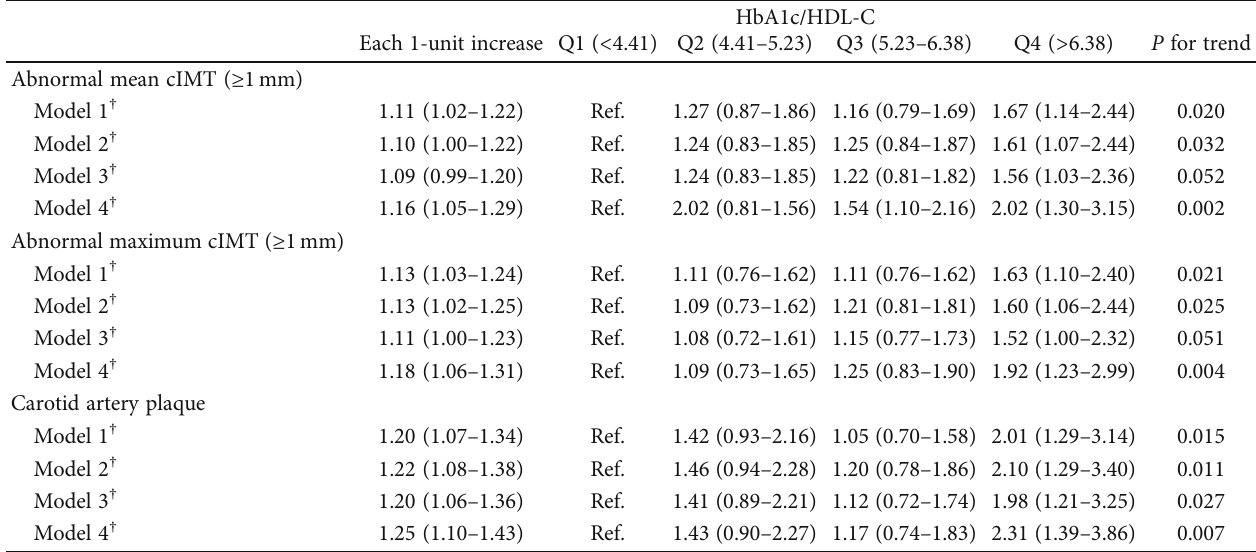
Table 4: OR (95% CIs) of abnormal cIMT and carotid artery plaque by quartiles of the HbA1c/HDL-C ratio in patients without DM ( n = 854 ).